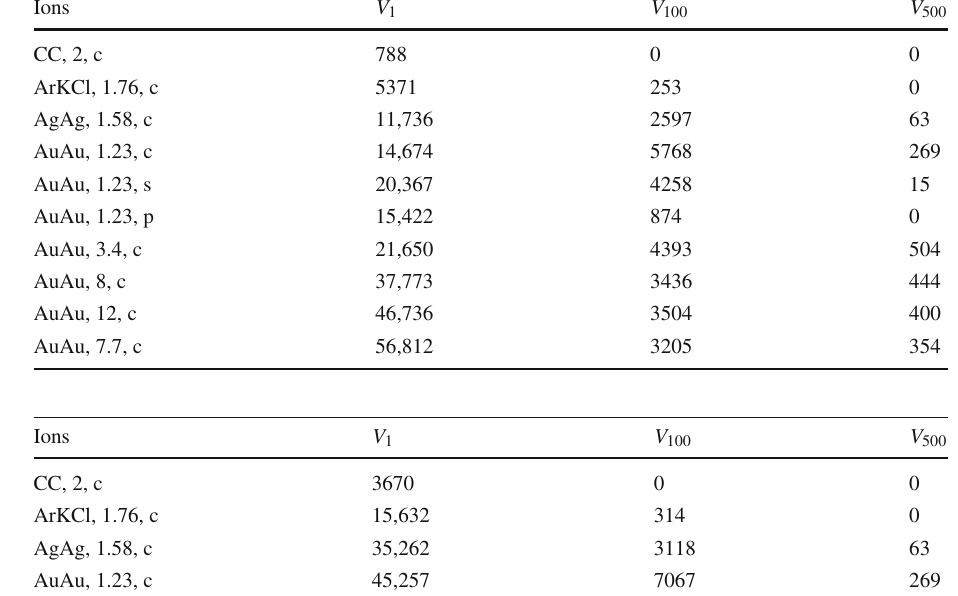
Table 12 Results for X < 0 . 3 and Y < 0 .